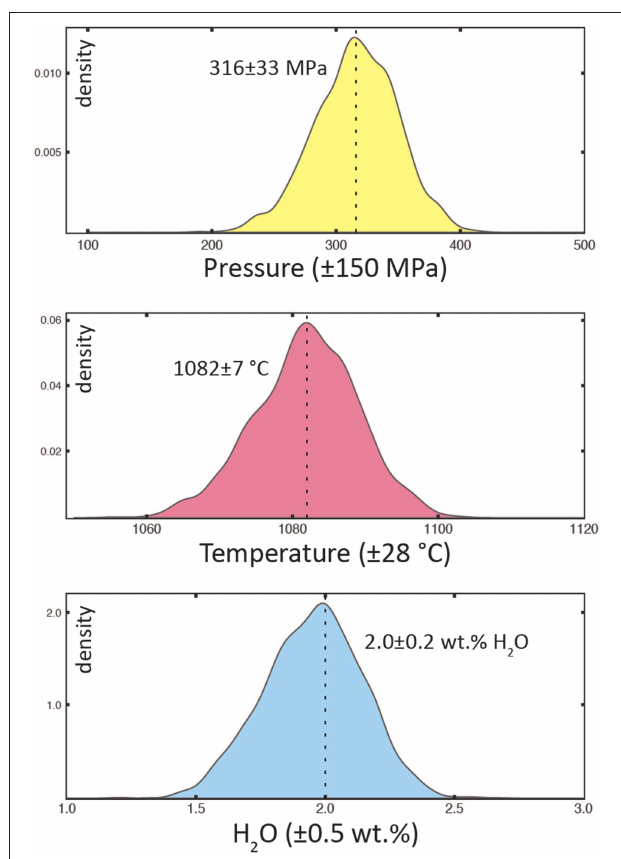
FIGURE 8 | Kernel Density Estimates (KDEs) of magmatic pressure, temperature, and melt water content according to the integrated clinopyroxene-melt calibrations by Mollo et al. (2018), optimised for alkaline basaltic compositions from Mt Etna and further adjusted to minimise deviations from Cpx-melt equilibrium [see details in section Estimating Clinopyroxene Crystallisation Conditions ( P-T- H2O)]. Dashed dotted lines and figures represent mean and standard deviation values for P-T- H 2 O estimates: 316 ± 33 MPa, 1,082 ± 7 ◦ C, and 2.0 ± 0.2 wt.% H 2 O ( n = 2,924). The constancy of thermobarometric and hygrometric results (within error of the calibrations: A MAM ± 150 MPa, 33 MAM ± 28 ◦ C, H MAM ± 0.5 wt.% H 2 O) indicate very stable conditions throughout the crystallisation of the megacrysts. Clinopyroxene-melt equilibrium tests are presented in Supplementary Figure 5